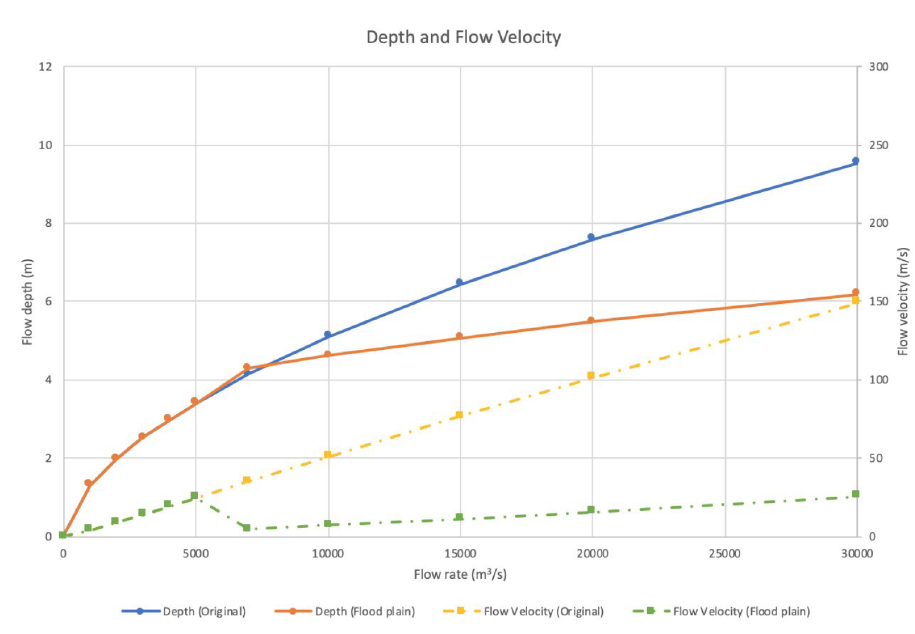
Figure 11. Flow depth and velocity as a function of flow rate (0–30,000 m 3